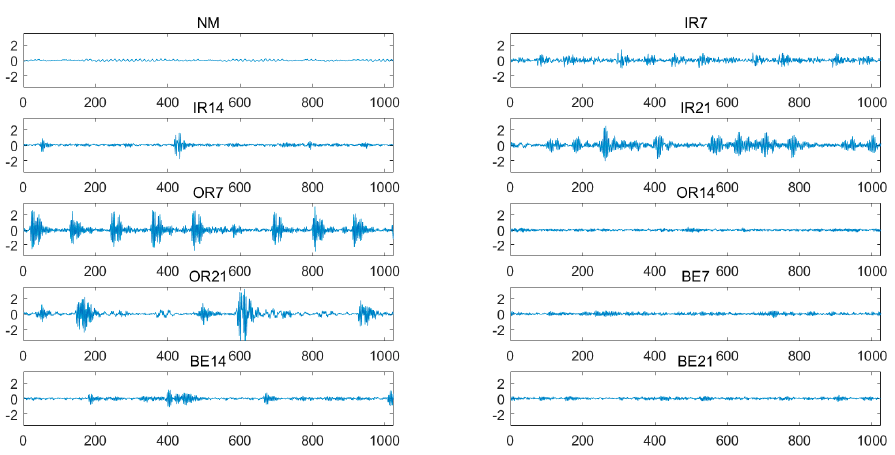
Figure 6. The vibration signal waveforms of rolling bearing in different fault states at load 0 hp.